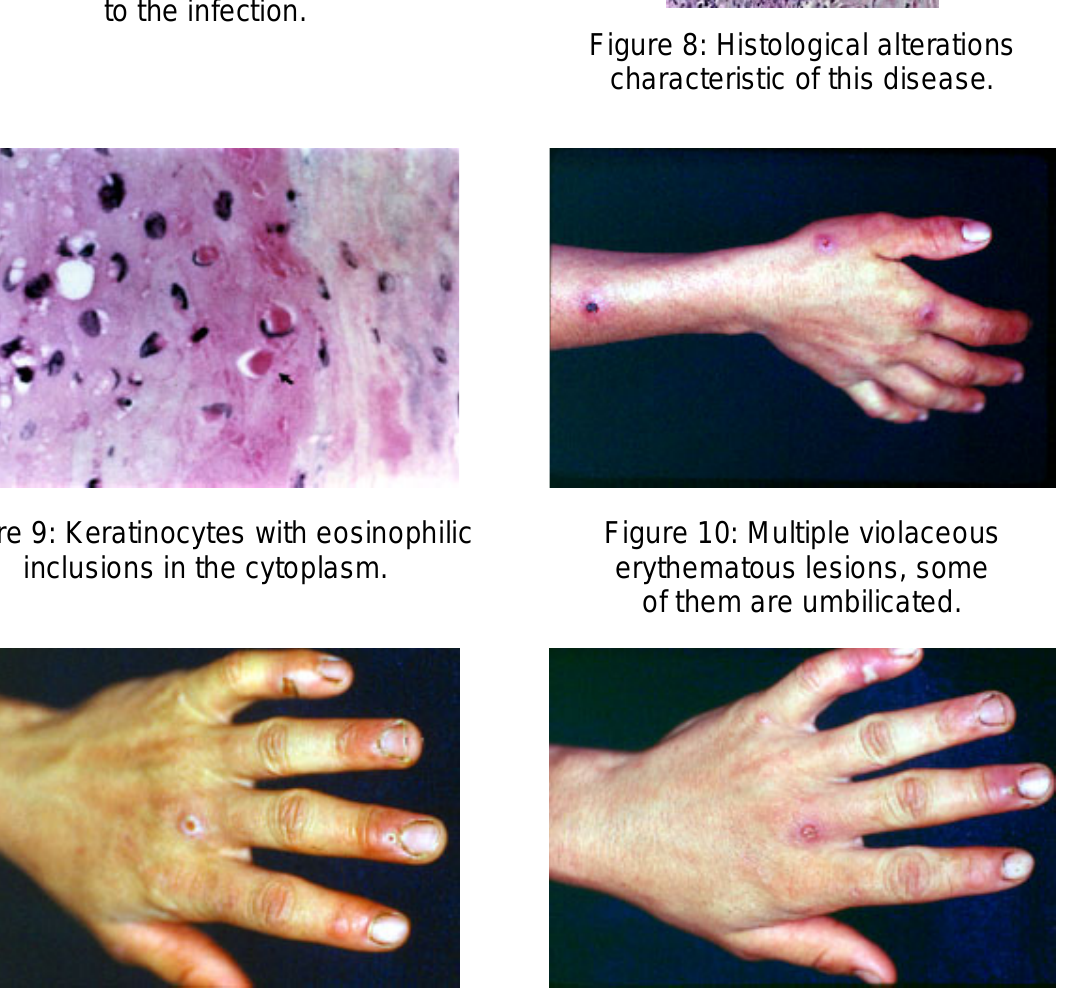
Figure 7: Lymphangitis secondary to the infection.